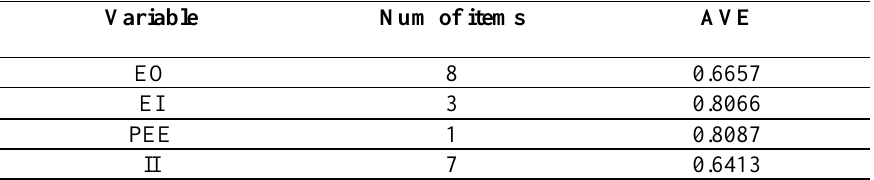
Table 07: AVE for the constructs